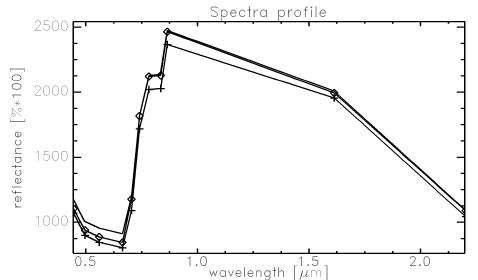
Figure 6: Spectra profiles collected in a cirrus area (no symbol: original; + : 1.38 µ m; ⋄ :